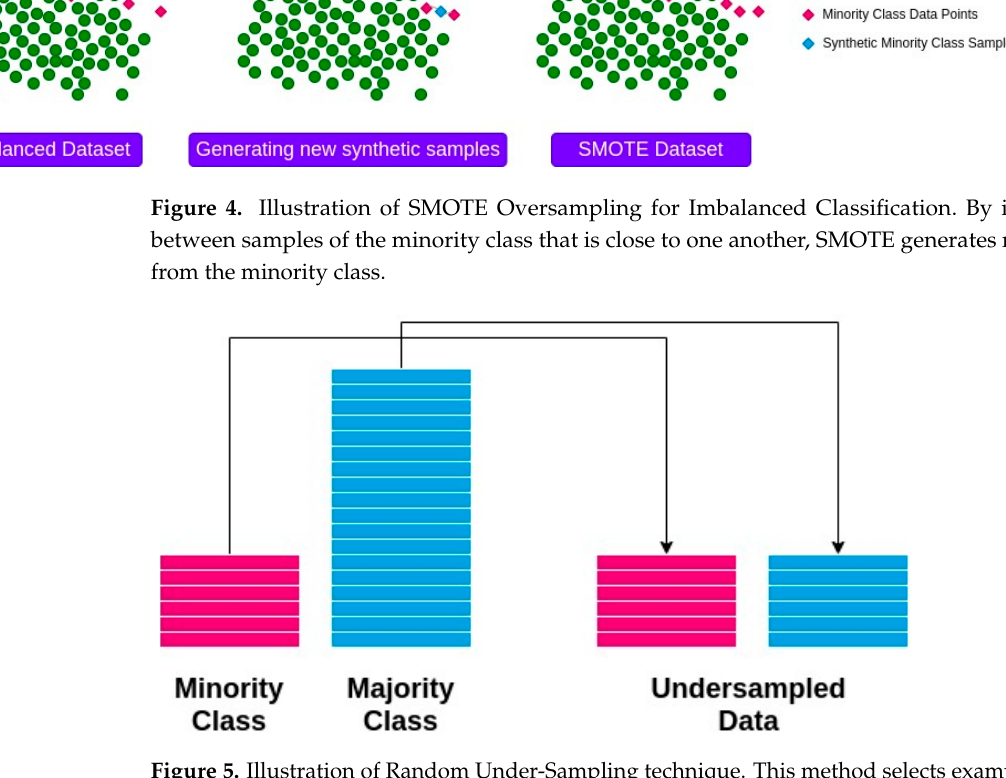
Figure 5. Illustration of Random Under-Sampling technique. This method selects examples from the majority class at random and removes them from the training dataset.